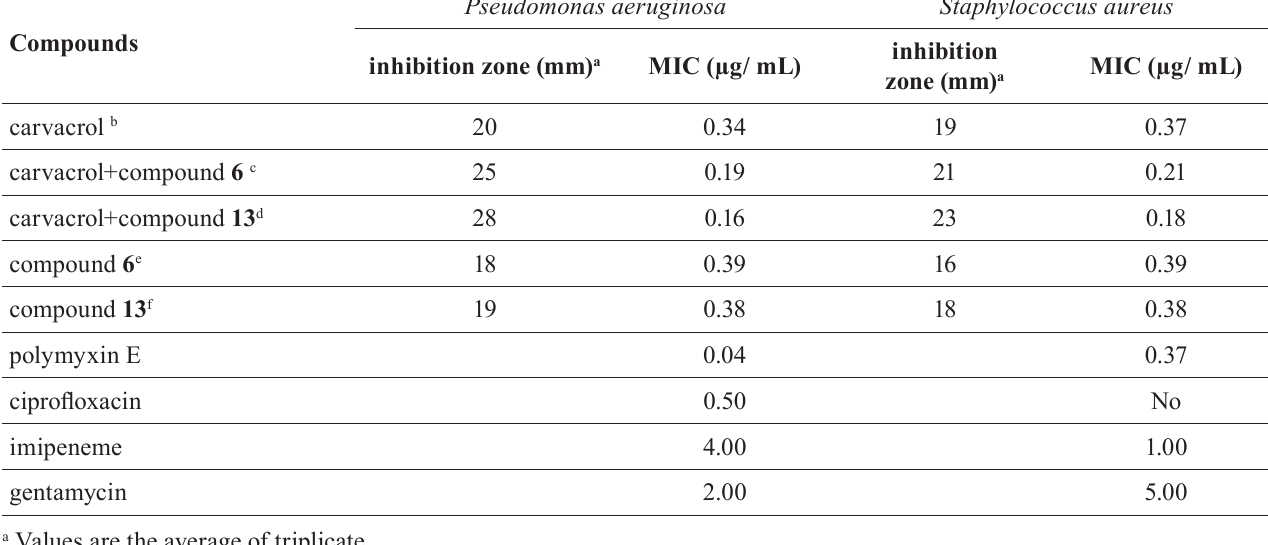
TABLE III - Antimicrobial activity of carvacrol, diosmetin 7-rutinoside ( 6 ) and linarin ( 13